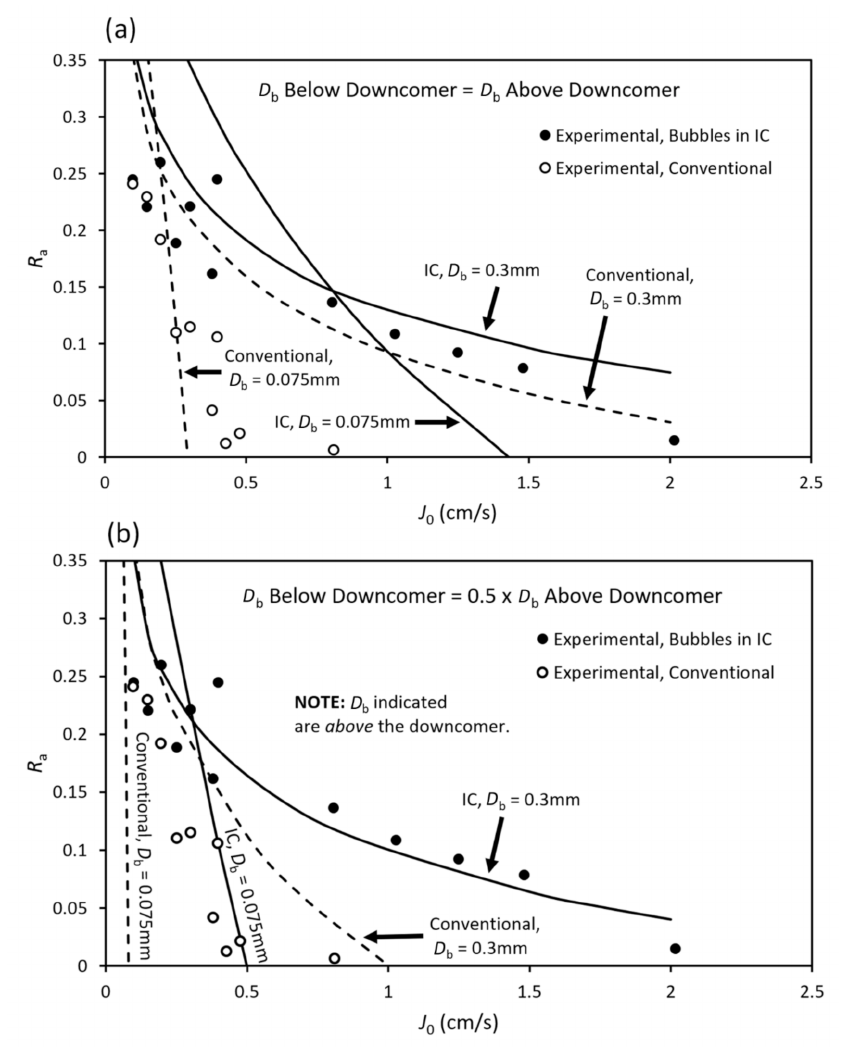
Figure 6. Modeled adsorptive recovery as a function of feed flux, for bubble diameters of 0.075 mm and 0.3 mm just above the downcomer, and with bubble diameter below the downcomer ( a ) the same and ( b ) half that above the